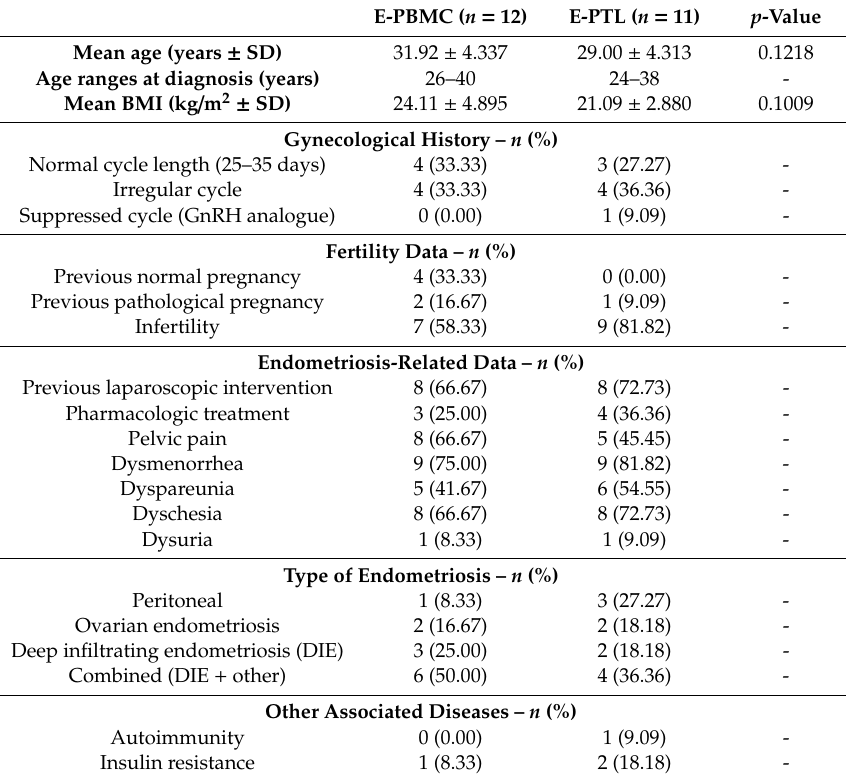
Table 1. Demographic and clinical characteristics of the endometriosis a ff ected